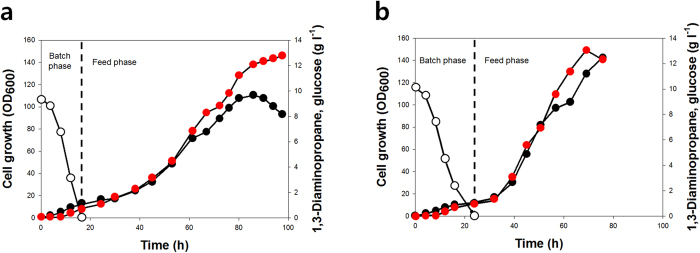
Fed-batch profile of (a) DP09 (p15DDoptppc) and (b) DP09 (p15DDoptpaspC). Cultivation profiles are represented by following symbols: black circle, cell growth; white circle, glucose concentration; red circle, 1,3-DAP concentration.